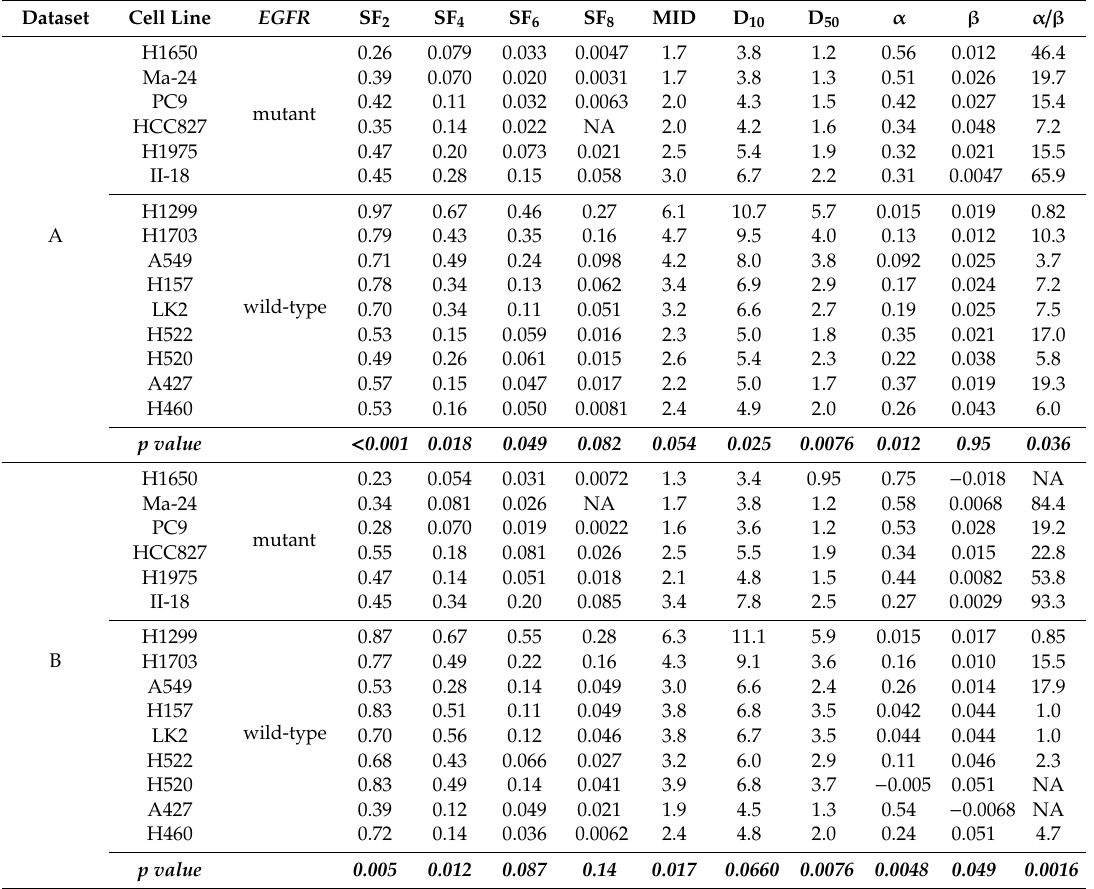
Table 1. Clonogenic survival parameters for datasets A and B.